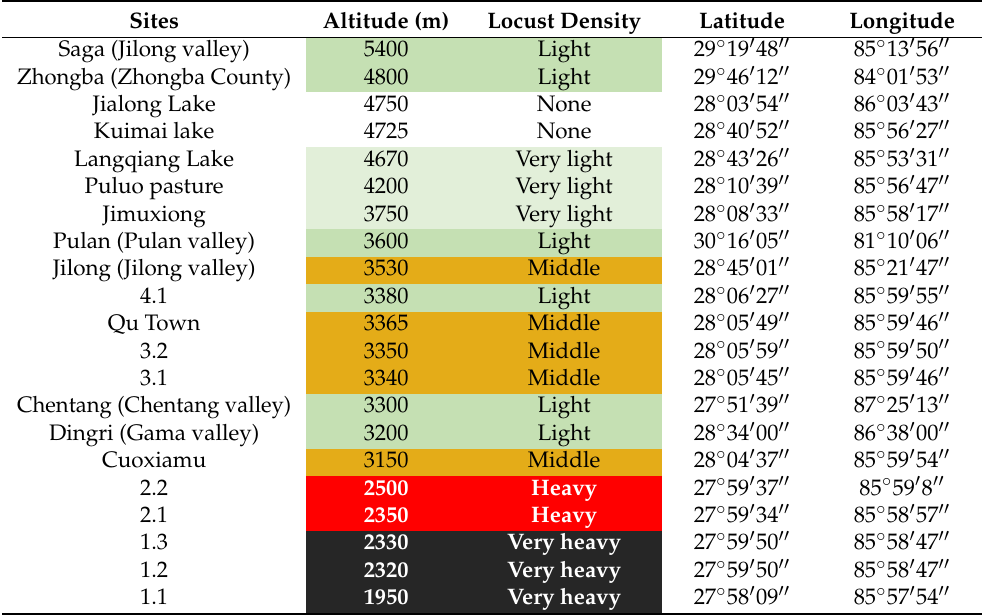
Table 1. Monitoring sites and assessment of desert locust numbers along some valleys in South Tibet. Sites Altitude (m) Locust Density Latitude